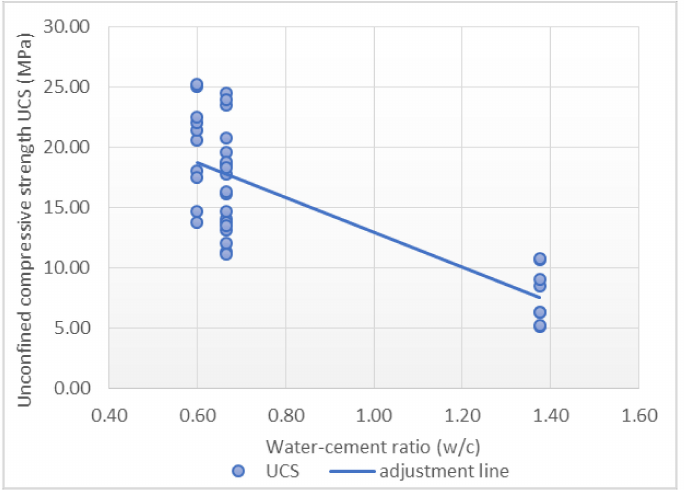
Figure 10. Relationship between water-cement ratio and unconfined compressive strength.